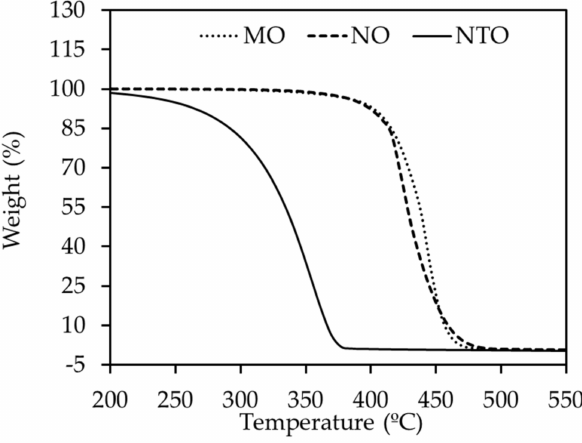
Figure 1. TGA curves of different oils. Table 3. The decomposition temperatures of different oils